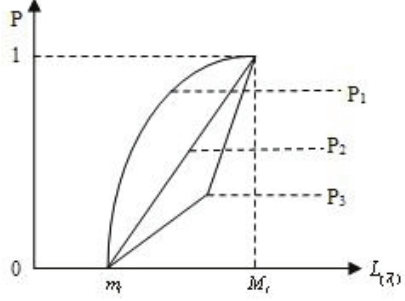
Figure 4.1. The geometric explanation of desirability